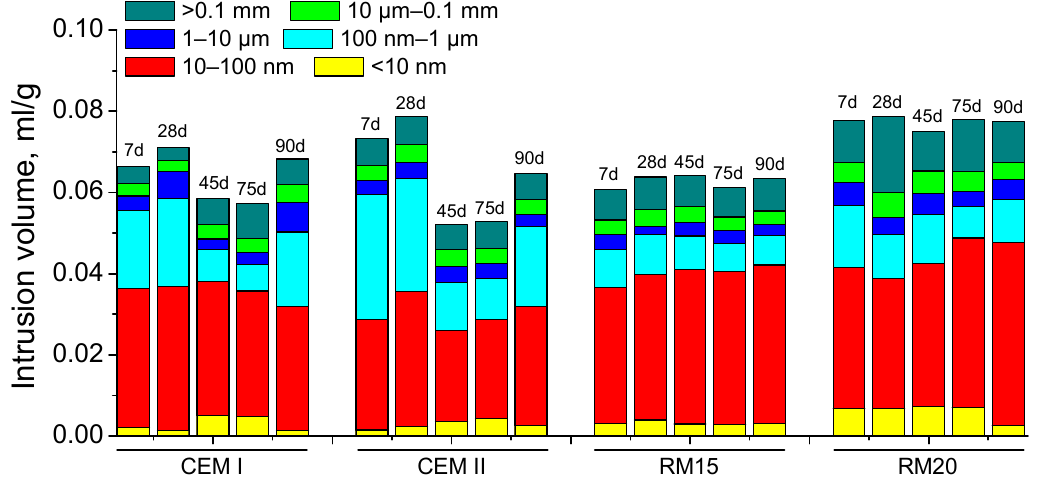
Figure 5. Pore size distributions noted for mortars with 15% (RM15) and 20% (RM20) red mud content. Pore size distributions of CEM I and CEM II mortars have also been included in order to facilitate the comparison between the abovementioned red mud mortars and those made using commercial cements.